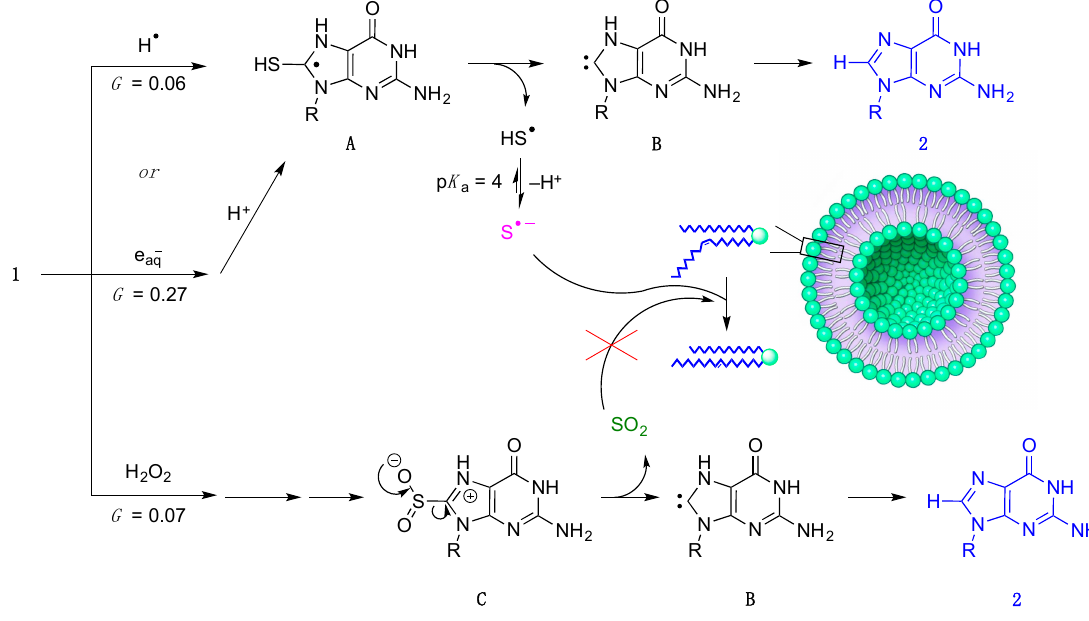
Figure 8. γ -radiolysis of 1 (0.25 mM) in N 2 -purged water at a natural pH, containing t BuOH (0.25 M) at a dose rate of 1.85 Gy·min –1 . a ) HPLC runs of the reactions. The HPLC peaks of 1 are highlighted in red, while the peaks of guanosine ( 2 ) are highlighted in blue. b ) The chemical irradiation yields G (– 1 ) (  ) and G ( 2 ) (  ) as function of the irradiation dose. The line extrapolated to the zero dose leads to the G values reported in the